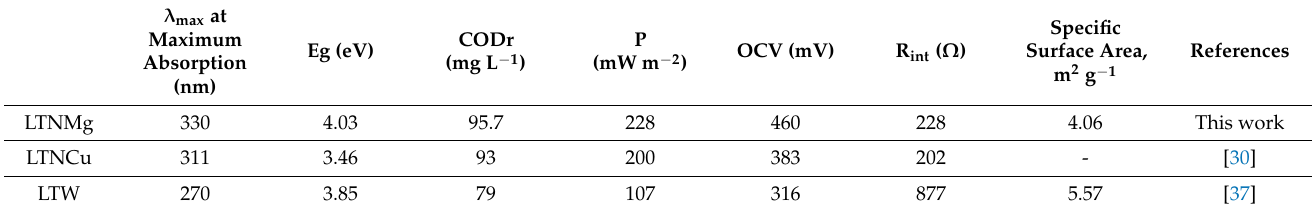
Table 2. Comparison of recent results of photocatalysts tested in MFCs.